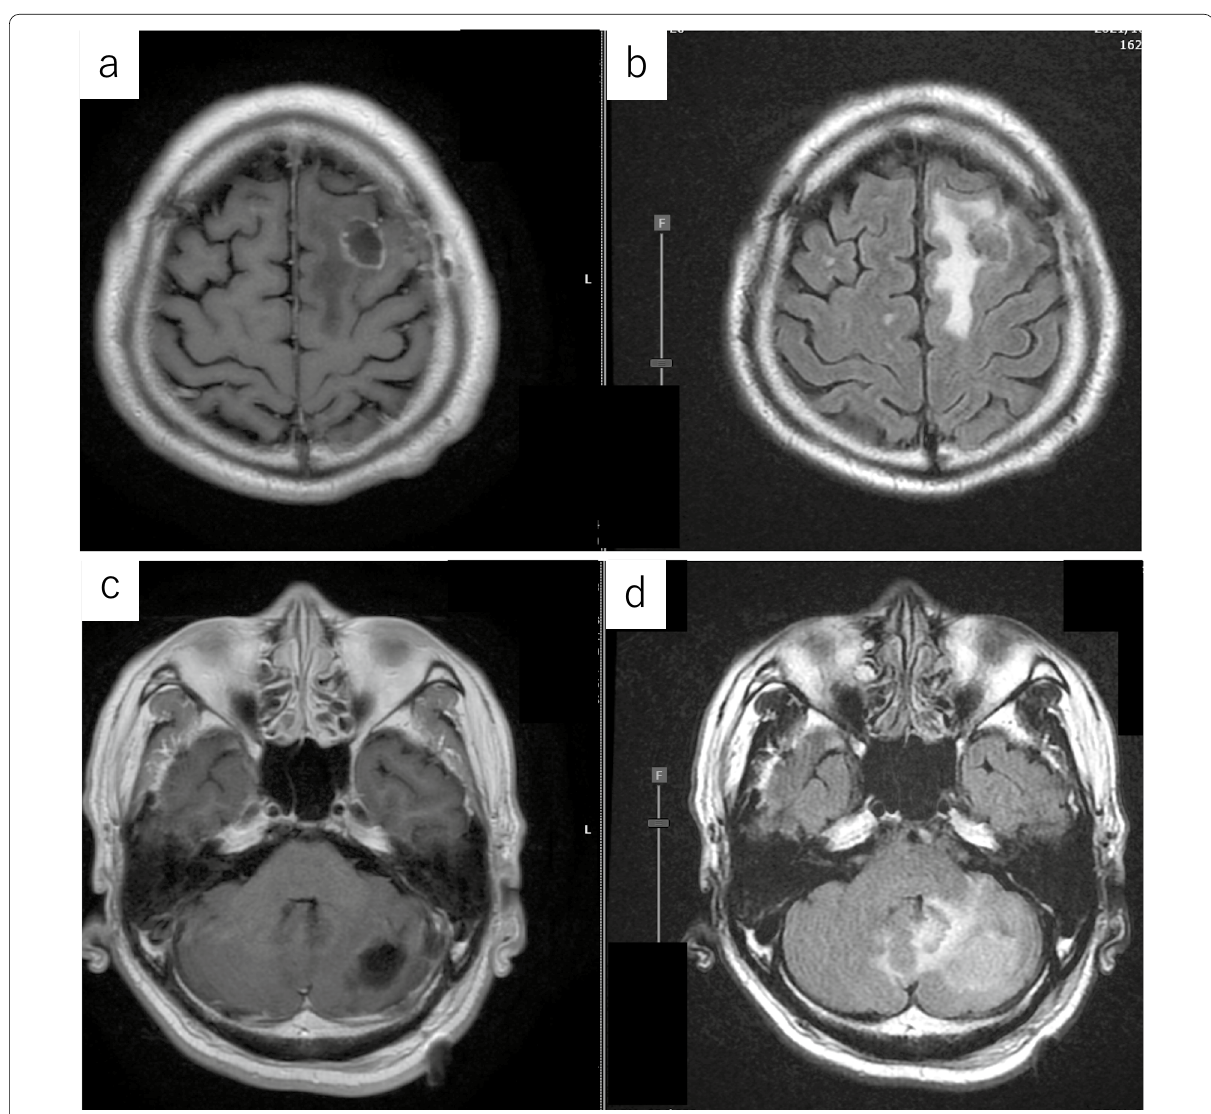
Fig. 4 Magnetic resonance imaging after tumor resection. a , c : T1-weighted image: The tumor is removed. b , d T2-weighted image: edema around the resection area has